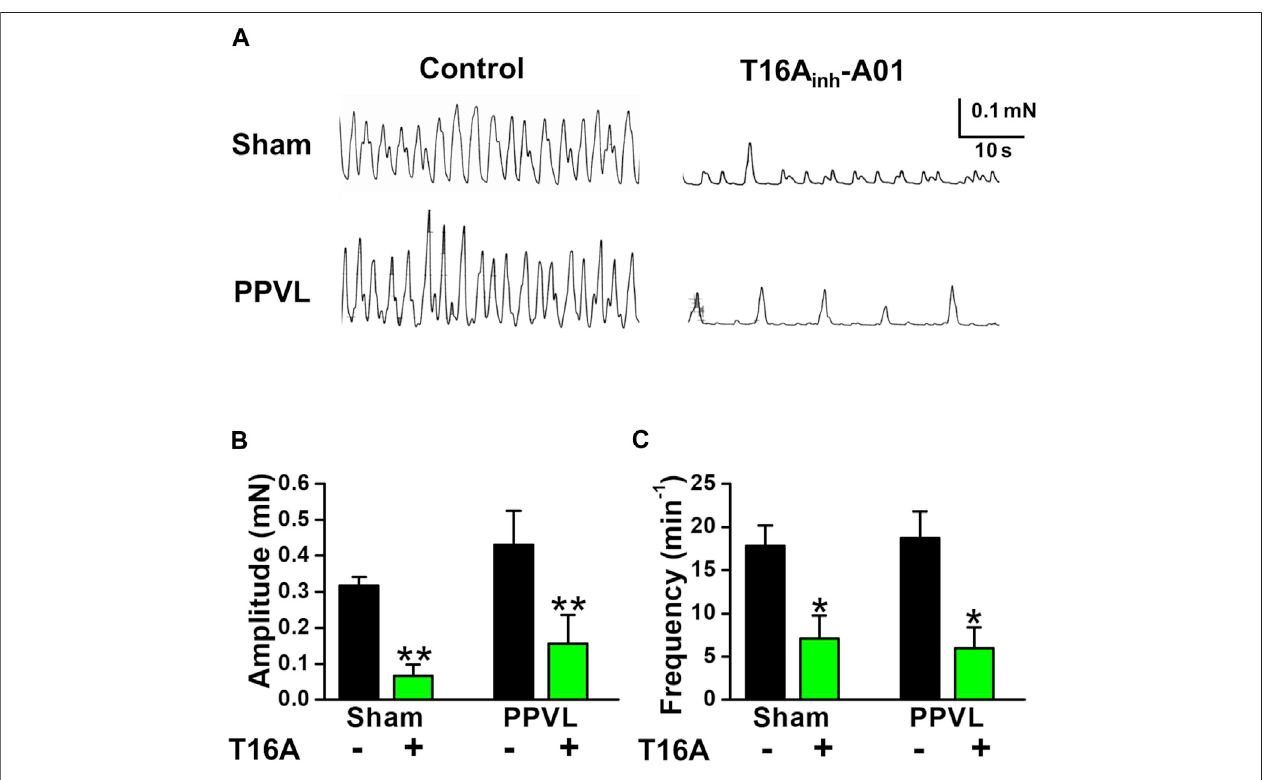
FIGURE 5 | Spontaneous contraction in PVSMs from PPVL mice. The parameters of spontaneous contraction and effects of T16A inh -A01 on spontaneous contraction in PVSMs were examined in PPVL mice. (A) Representative recordings of spontaneous contraction in the absence and presence of 30 μ M T16A inh -A01 in sham- and PPVL-PVSMs. (B) The amplitude of spontaneous contractions in the absence and presence of T16A inh -A01 (T16A) in sham- and PPVL-PVSMs ( n = 5). (C) The frequency of spontaneous contractions in the absence and presence of T16A inh -A01 (T16A) in sham- and PPVL-PVSMs ( n = 5). Data are presented as means ± S.E. * p < 0.05, ** p < 0.01 versus